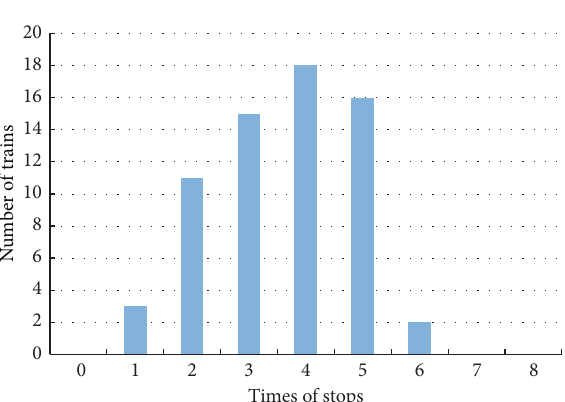
Figure 13: Times of train stopping at intermediate stations.